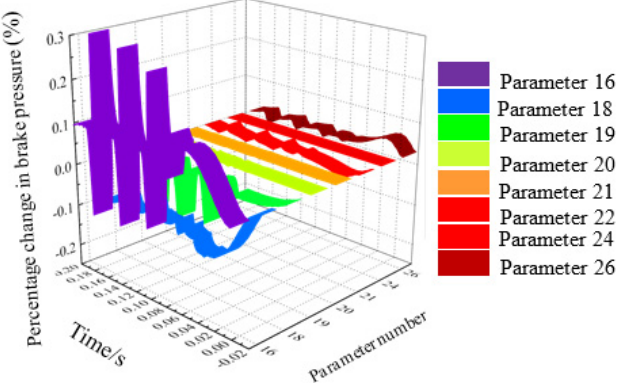
Figure 9. The change of x 8 with power spool part parameter varieties by 10%.